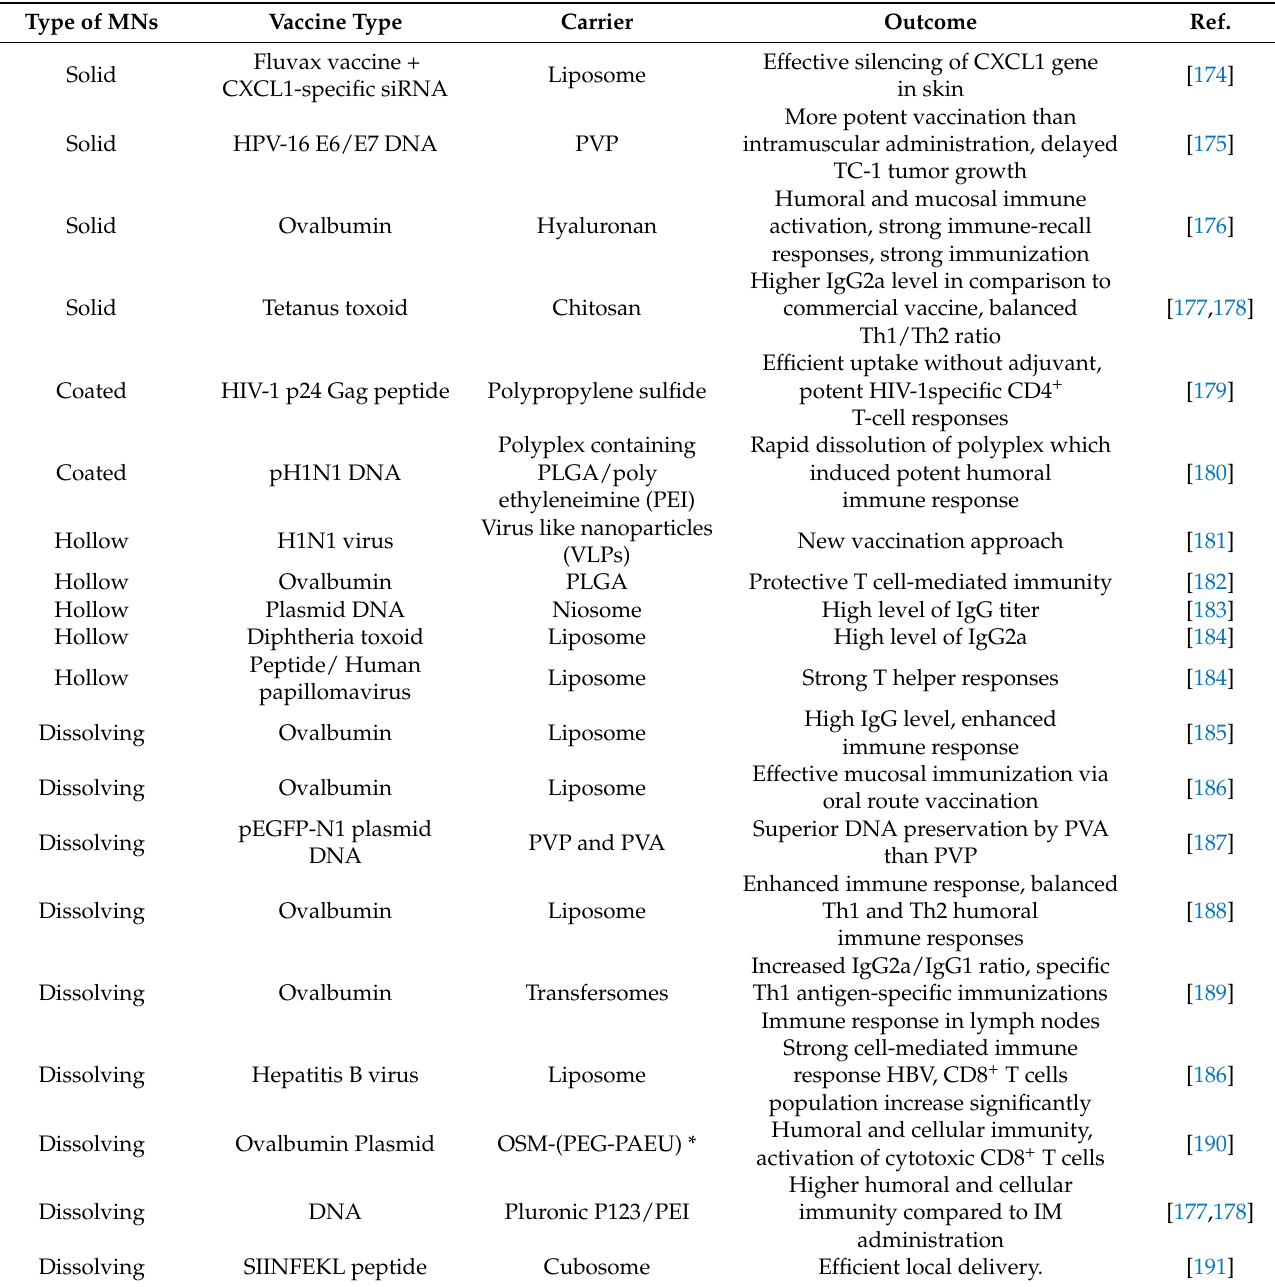
Table 3. Vaccine delivery studies with different MNs regarding the type of vaccine and